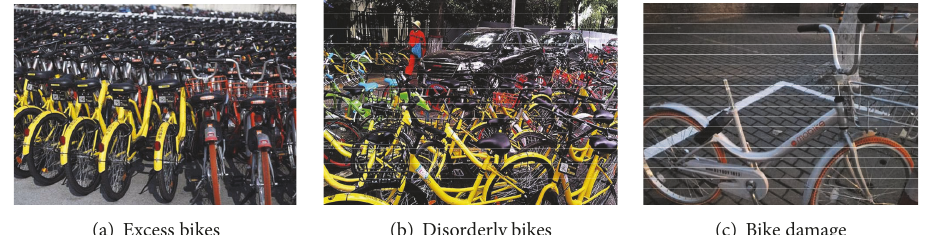
Figure 2: Problems with